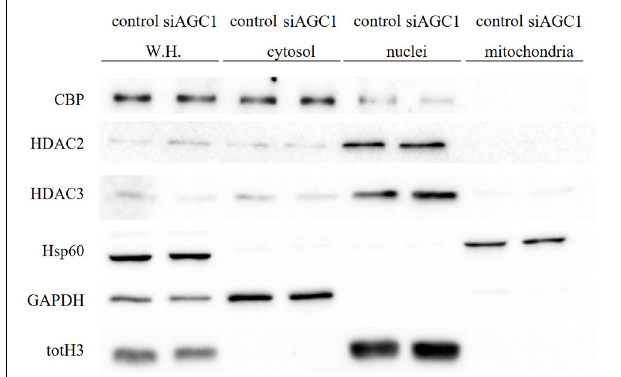
FIGURE 5 | Proliferation factor c-Myc, acetyltransferase CBP and HDAC isoform 2 and 3 do not show alterations in the subcellular localization in siAGC1 Oli-Neu cells. WB analysis of c-Myc, HAT–CBP and HDAC2 and HDAC3 expression in the whole homogenate (WH), cytosolic, nuclear, and mitochondrial fractions from siAGC1 and control Oli-Neu cells; HSP60, GAPDH, and totH3 were used as mitochondrial, cytosolic, and nuclear specific markers,